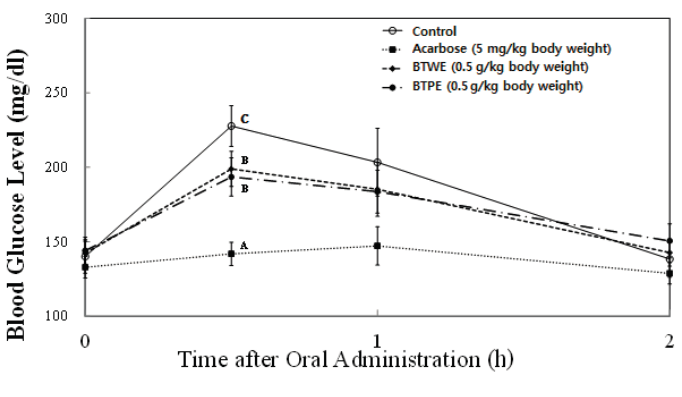
Figure 5. Comparison of postprandial blood glucose-lowering effects of green tea water extract (GTWE) and green tea pomace extract (GTPE) in a sucrose loading test. After a 24 h fast, six-week-old, male SD rats were orally administered with sucrose solution (2.0 g/kg) with or without samples (GTWE, GTPE, and a positive control: acarbose). Each point represents Mean ± SD ( n = 5). A − C Different corresponding symbols indicate significant differences at p < 0.05 by Duncan’s test.